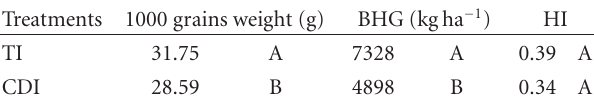
Table 12: 1000 grains weight, biomass of harvested grain (BHG) and harvest index (HI) measured for total irrigation (TI) and irrigation with controlled deficit (CDI)